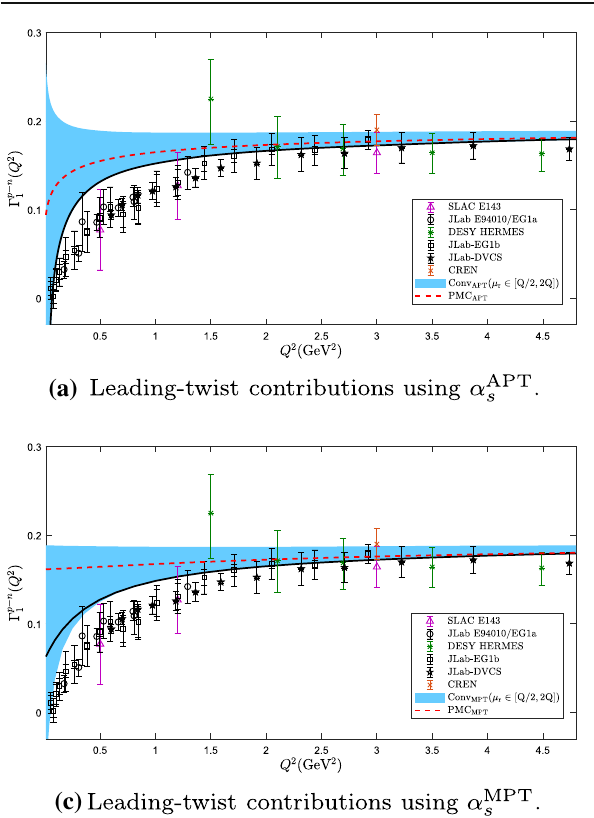
Fig. 2 Perturbative leading-twist contributions to the spin structure − n ( Q 2 ) up to N 3 LO versus momentum Q, under four α function (cid:3) p 1 models: a the APT model; b the WEB model; c the MPT model; and d theCONmodel.Thesolidlineisforconventionalscalesettingapproach